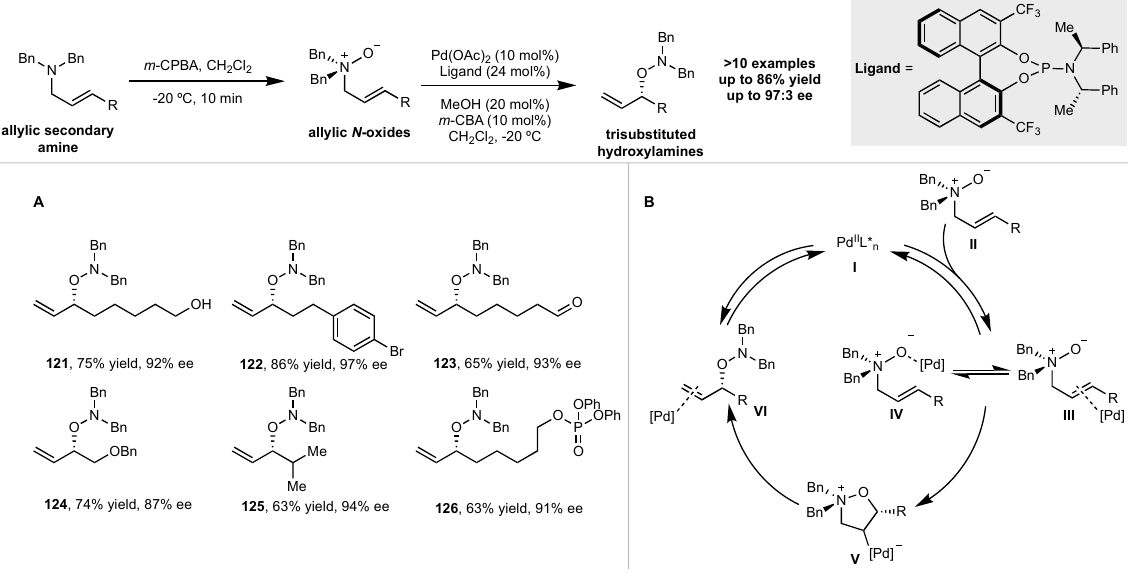
Scheme 12. Tambar’s enantioselective [2,3]-sigmatropic rearrangement of allylic amine N -oxides for the synthesis of trisubstituted hydroxylamines. ( A ) Selected examples of the transformation. ( B ) Proposed catalytic cycle [67].